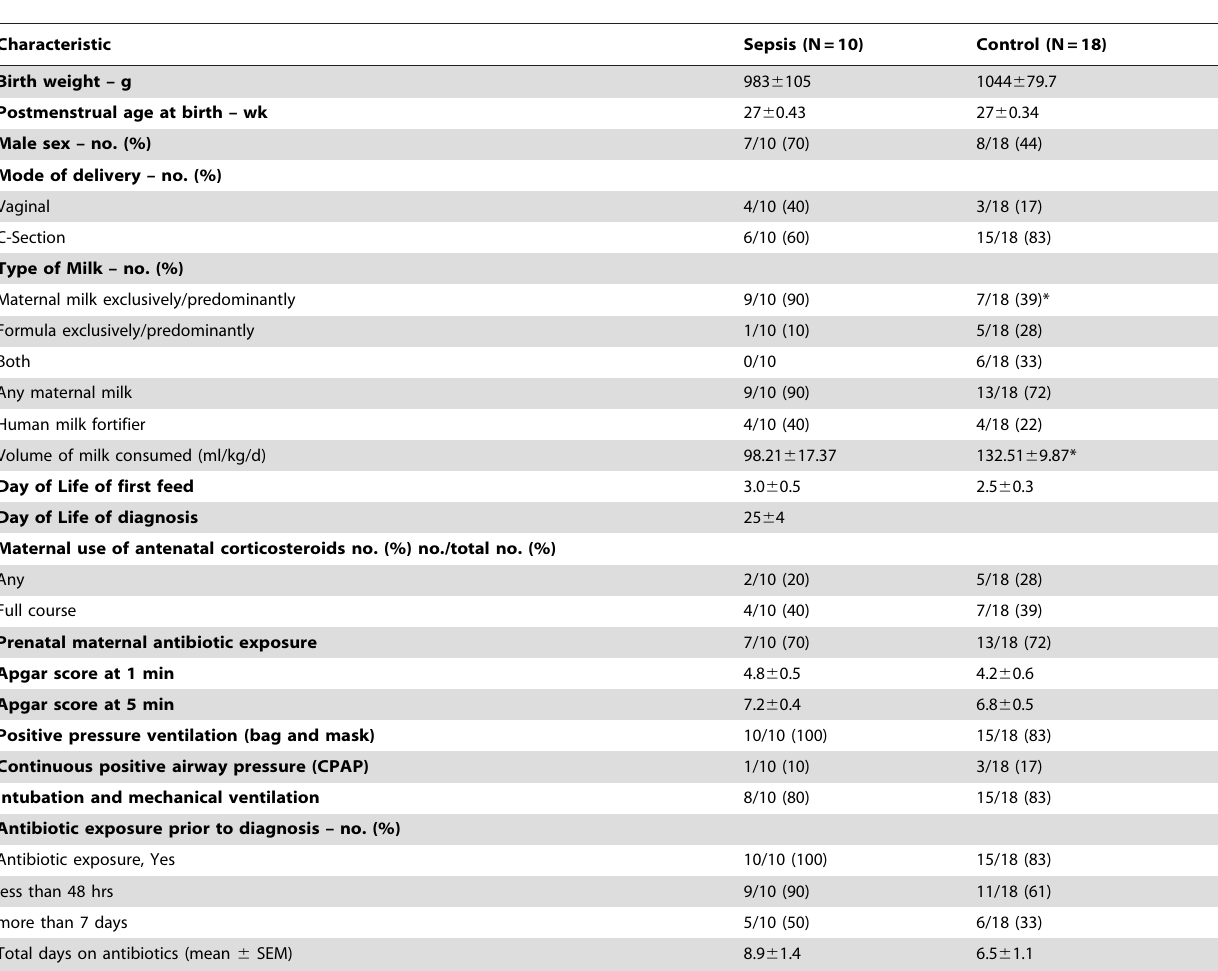
Table 1. Baseline Characteristics of the Infants. (Mean 6